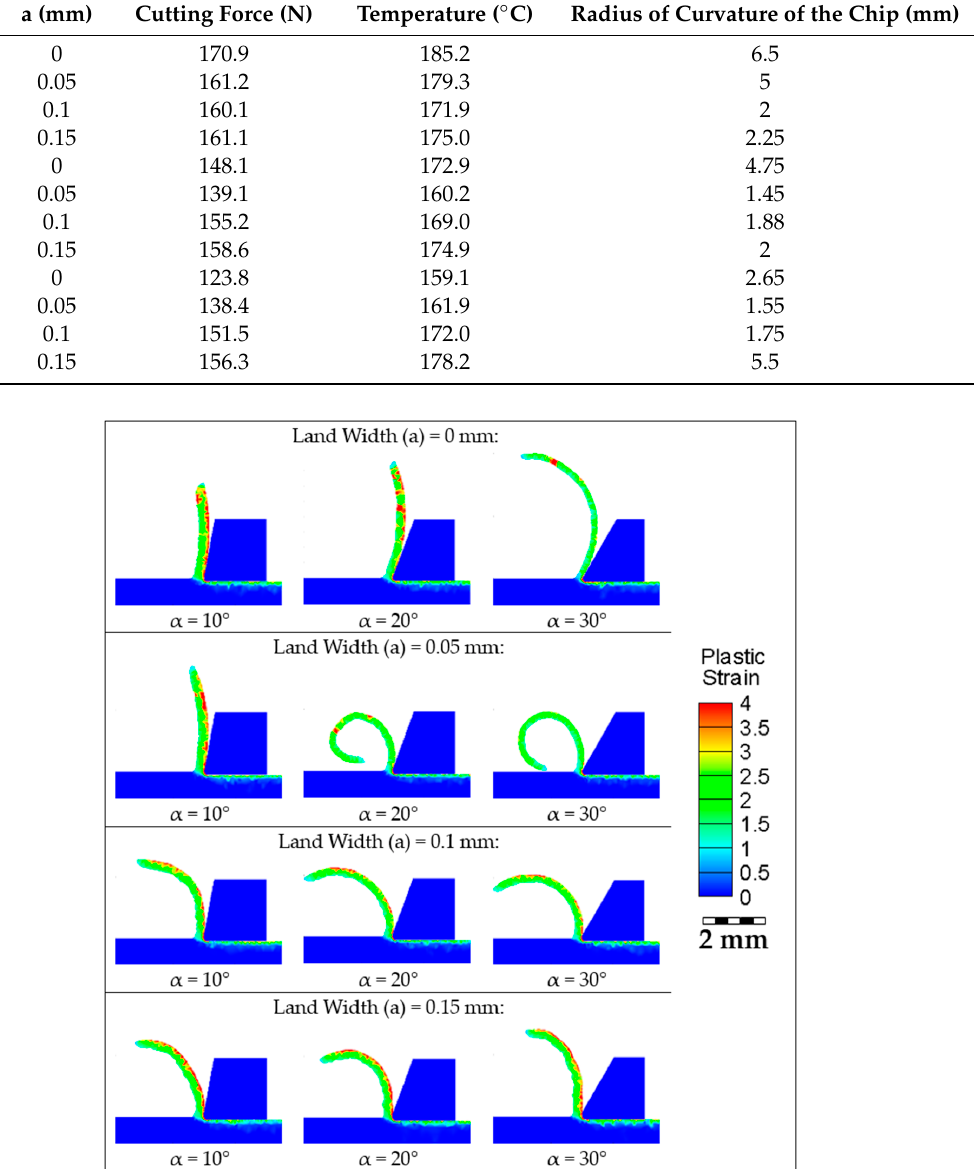
Figure 4. Result of chip curling simulations.